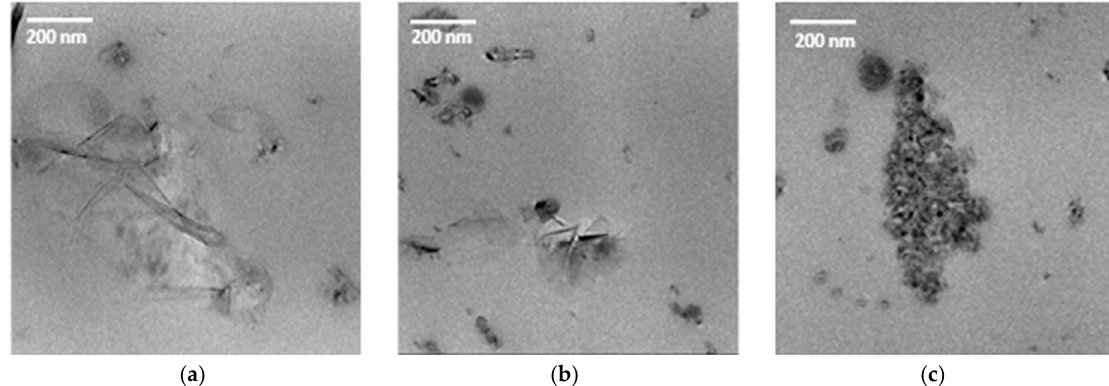
Figure 2. TEM micrographs of the bifiller composite films at high magnification, as indicated by the bar: ( a ) 4.5GNP/1.5CNT/PLA; ( b ) 1.5GNP/4.5CNT/PLA; and ( c ) 3GNP/3CNT/PLA.